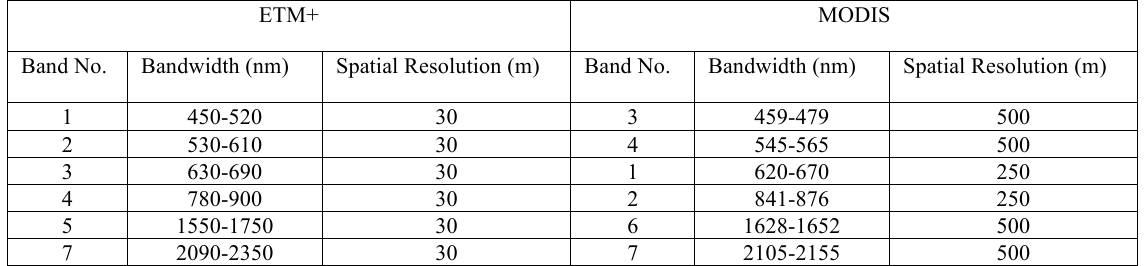
Table 1. The corresponding bandwidths and spatial resolution in ETM+ and